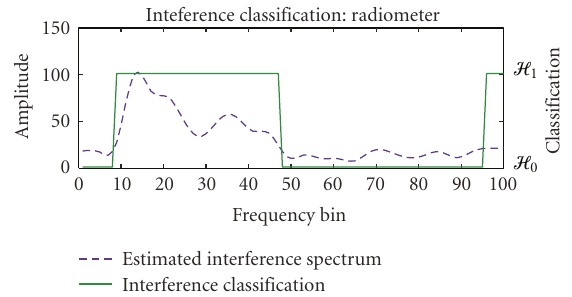
Figure 7: An example interference classification produced using information theoretic criteria. The classification should be com- pared against reference sample vector interference spectrum shown in Figure 2. In this example, this method mostly failed to detect the low power interferer occupying frequency bins 64 through to 77 and produced several type I and type II errors.